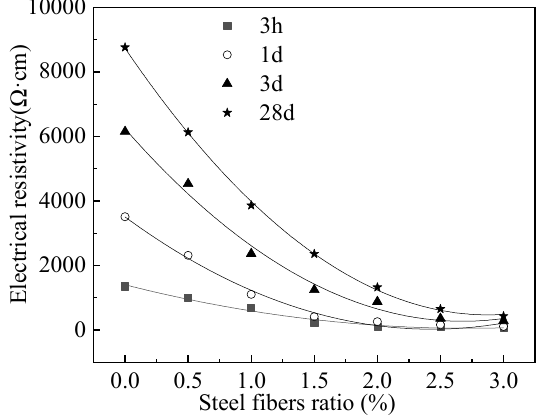
Figure 9. Electrical resistivity of MPC-RPC. Table 4. The fitting results of the relationship between ρ and V .